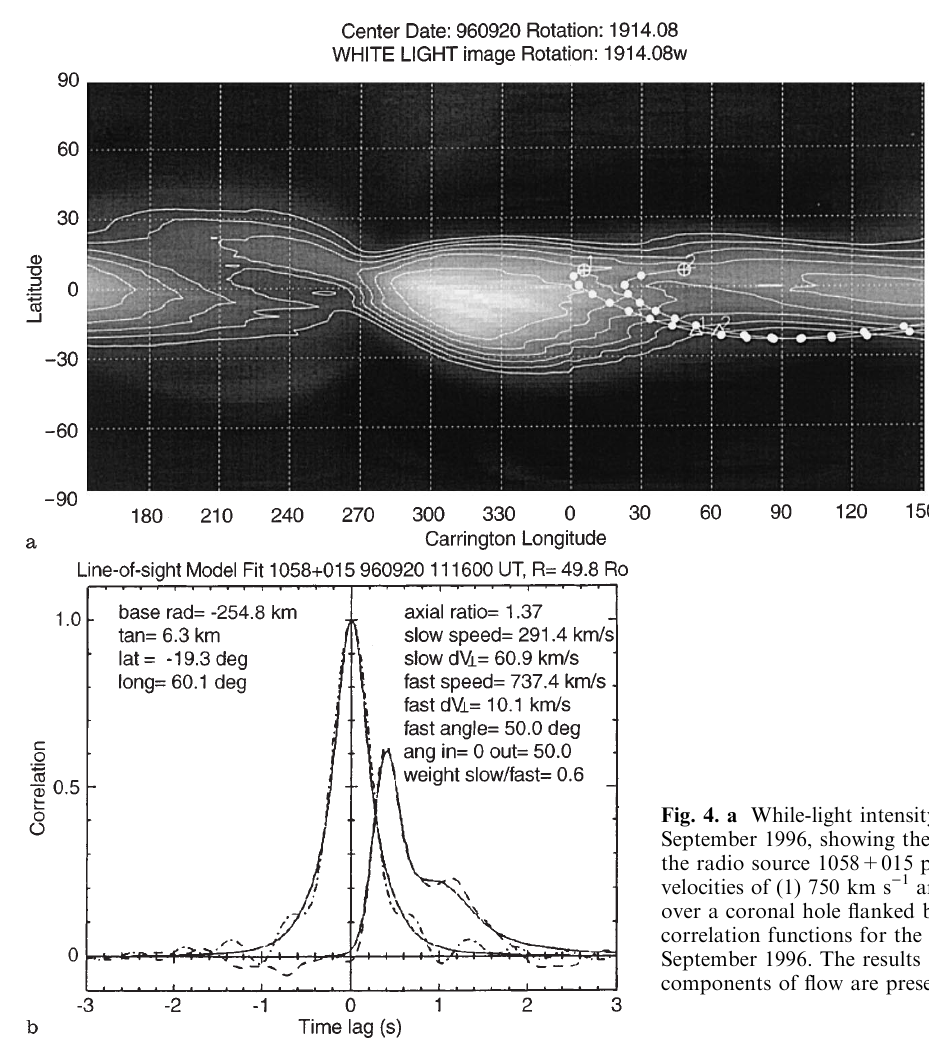
Fig. 4. a While-light intensity map of the corona at 1.7 R on 9 September 1996, showing the ray-path for EISCAT observations of the radio source 1058+015 projected down to 1.7 R with assumed velocities of (1) 750 km s ) 1 and (2) 325 km s ) 1 . The ray-path passes over a coronal hole flanked by bright regions. b Auto- and cross- correlation functions for the observation of 1058+015 on 9 September 1996. The results show that distinct fast and slow components of flow